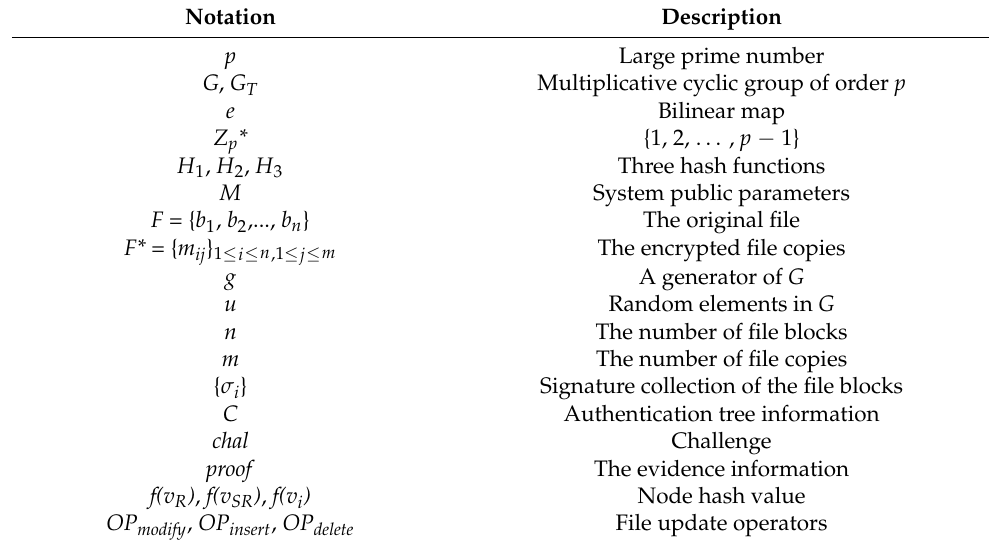
Table 1. Notations in the proposed